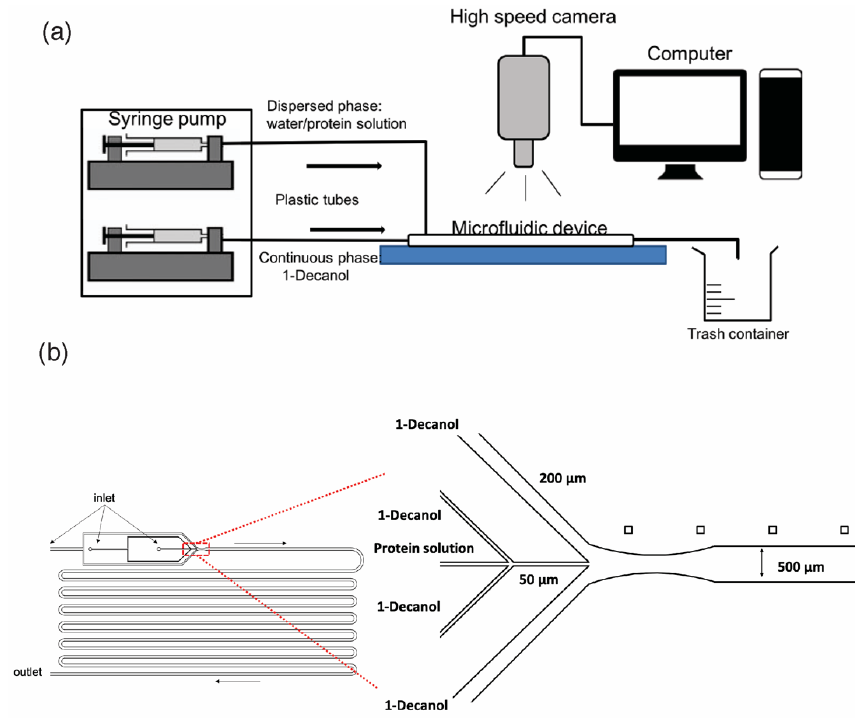
Figure 2. The experiment setup ( a ) and the scheme of the flow-focusing structure to generate micro- droplets ( b